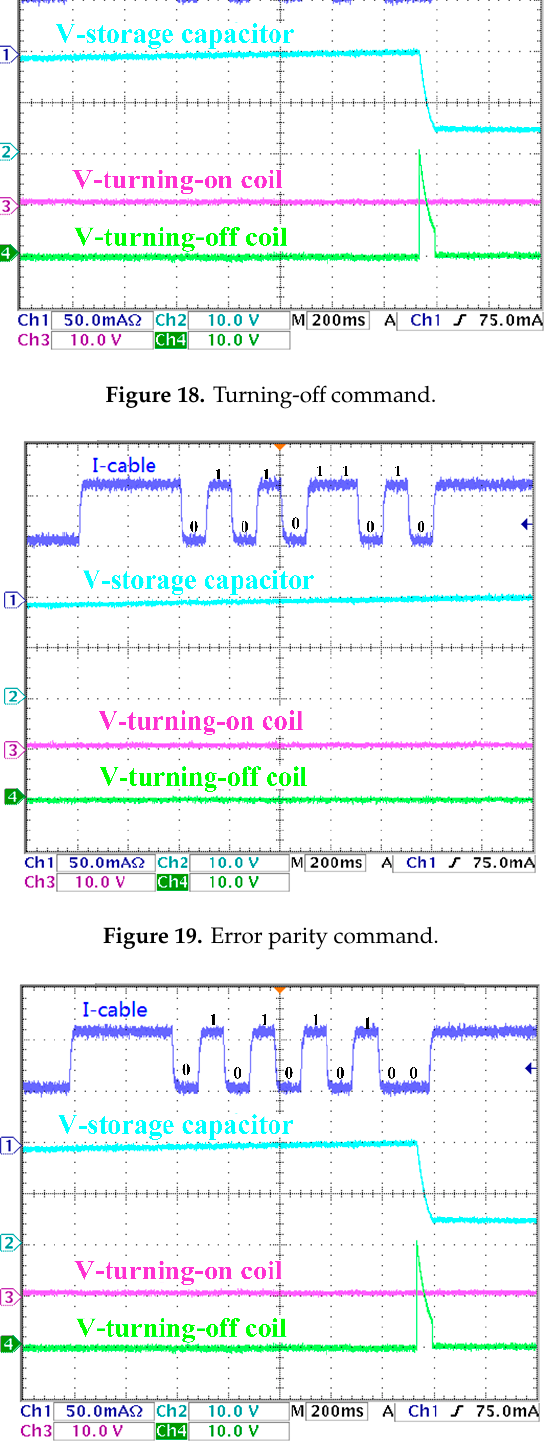
Figure 20. Error address command.